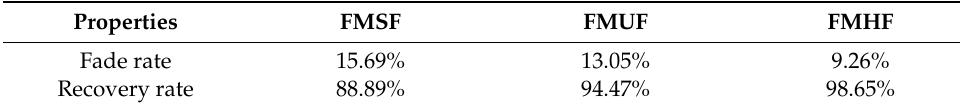
Table 5. Fade and recovery rates of the developed composite materials.